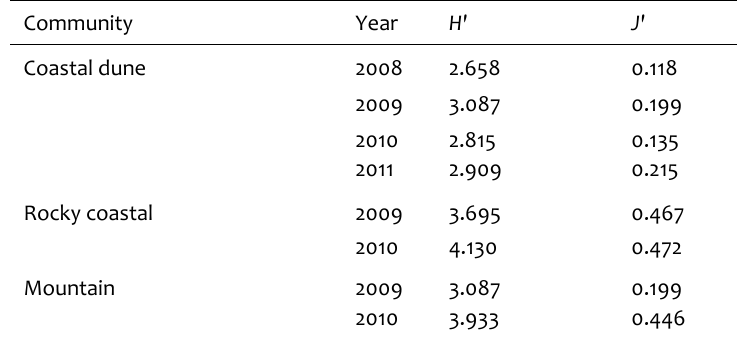
Table 3. Shannon index diversity ( H’ ) and Pielou’s index ( J’ ) in each year and community: coastal dune community, a rocky coastal community and a mountain community.